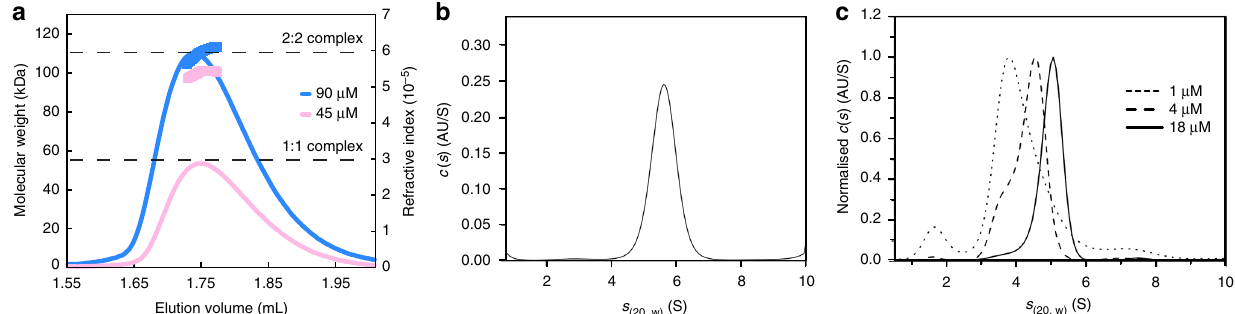
Fig. 3 The Drosophila PR-DUB forms a bidentate complex. a SEC-MALLS analysis of Calypso – ASX. Elution pro fi les of the puri fi ed Calypso – ASX complex at 90 and 45 μ M monitored by differential refractive indices (lines); the weight averaged molecular masses (Mw) are shown with symbols. Dashed lines correspond to the size of the 1:1 (55 kDa, bottom) and 2:2 (110 kDa, top) Calypso – ASX complex. b A c(s) distribution of Calypso – ASX from sedimentation velocity AUC at 40 µ M. The RMSD for the fi t was 0.005 and the Runs-Test Z score was 2.25. The frictional ratio was fl oated and converged to a value of 1.00 (see Supplementary Fig. 4a, c). c c ( s ) distributions of Calypso – ASX at 1, 4, and 18 µ M. The residuals for each fi t were randomly distributed with RMSD values of 0.008, 0.01, and 0.006 respectively (see Supplementary analytical SEC experiments. Consistent with our previous data, the elution pro fi les of Calypso(M288R) – ASX and Calypso (N292R) – ASX were considerably shifted compared to the wild- type complex (Fig. 4b).